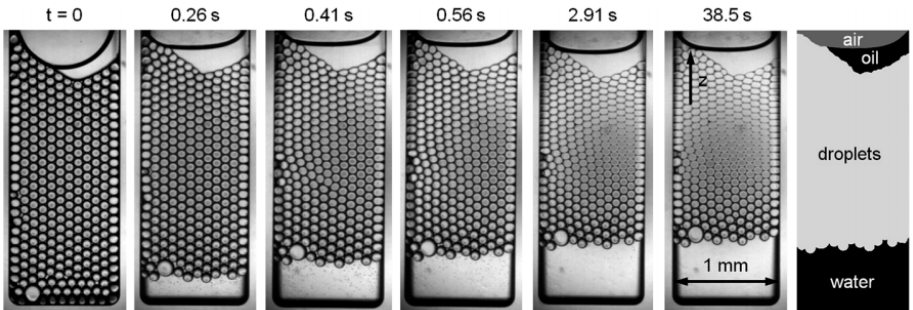
Figure 10. Images obtained with the micro centrifuge in which a small container filled with droplets is spun around at high g-force. The emulsion used in this experiment is stabilized by 10 mM SDS, and droplets have a diameter of 97 µm. Through image analysis, the amount of separated oil, aqueous phase and droplets, as well as droplet size was determined (marked in the last image). Reproduced from Krebs et al. (2013) [76] with permission from The Royal Society of Chemistry.